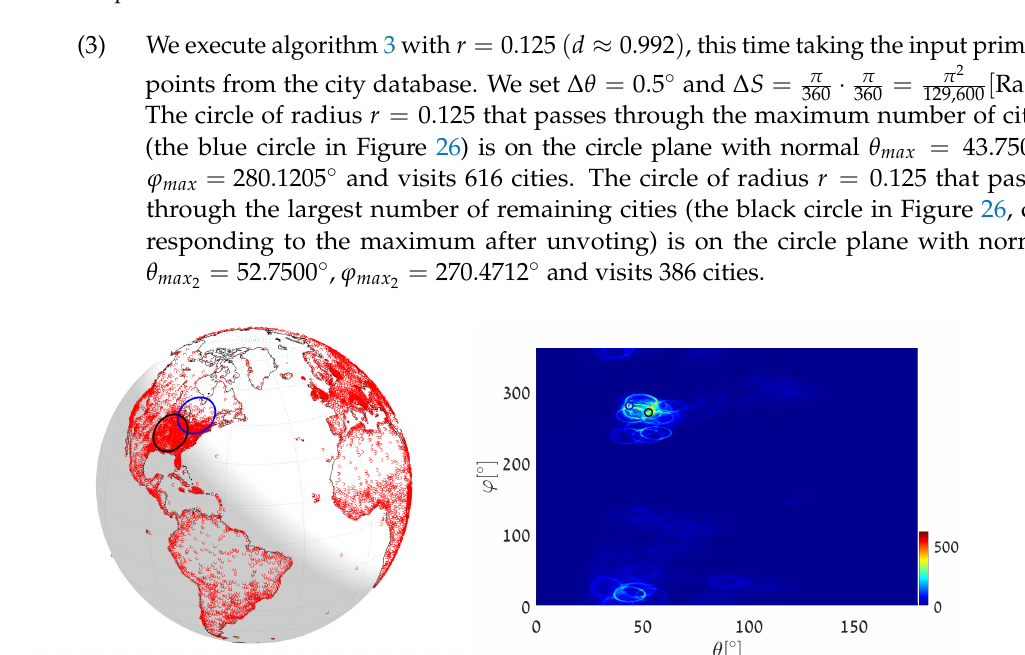
Figure 25. Executing Algorithm 3 with r = 0.5 on the airport database. ( Left ) The blue circle passes through the maximum number of airports (red dots). The red circle corresponds to the second maximum, following the unvoting process. ( Right ) Heat plot of the accumulator array M , showing the parameters of the two circles.